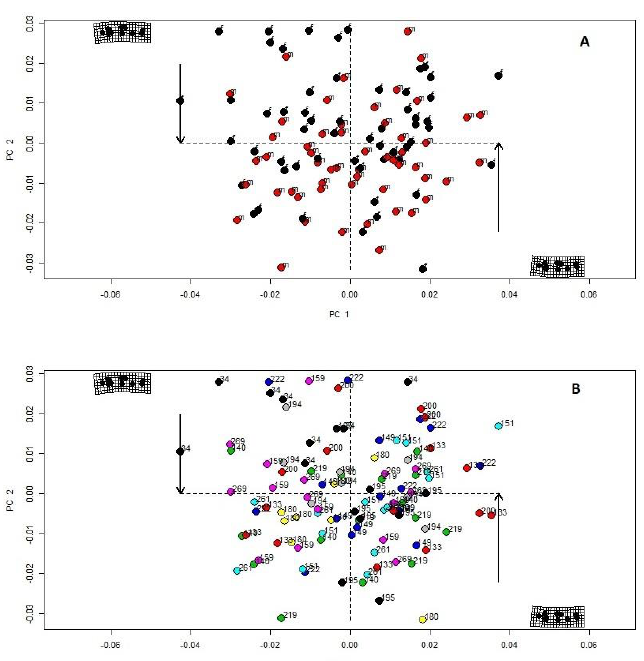
Figure 3. Principal components (PCA) of geometric morphometry based on 11 landmarks (Figure 2) of 111 individuals of Sabanejewia spp. based on specimens’ sex (( A ) black dots–females, red dots– males) from 15 localities differing in elevation (( B )numbers and colours represent locality elevation). Significant explanatory variables are identified by PERMANOVA (Table 1).